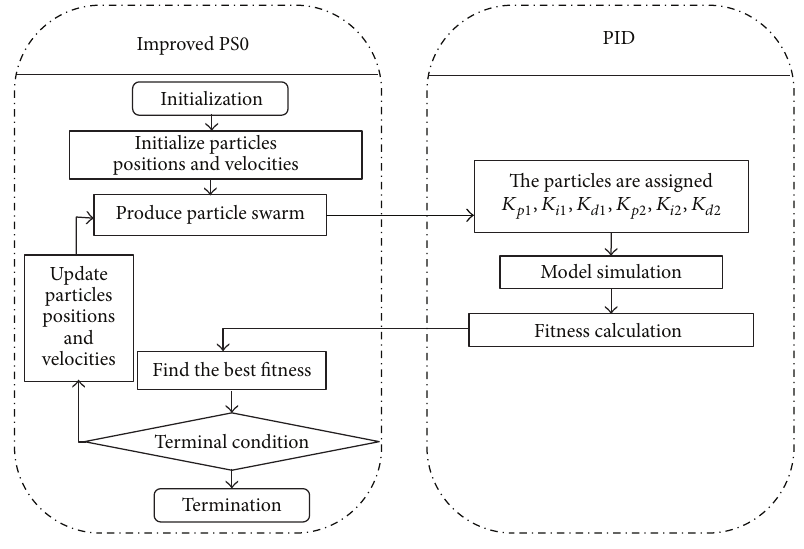
Figure 8: Optimization process for PID using improved